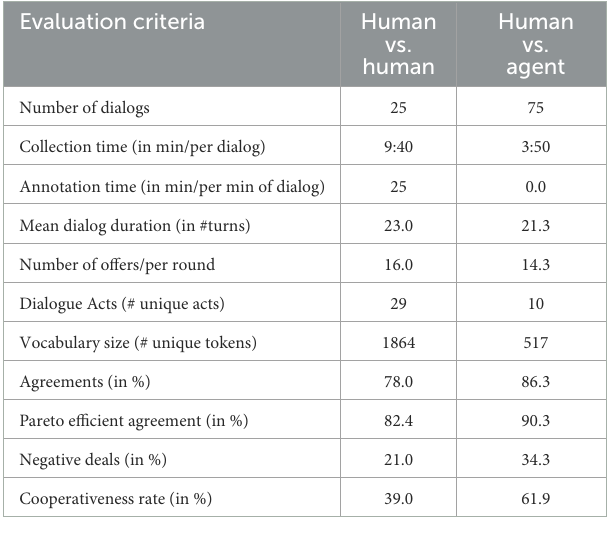
TABLE 6 Comparison of human-human and human-agent negotiation performance in the LICA corpus. Evaluation criteria Human